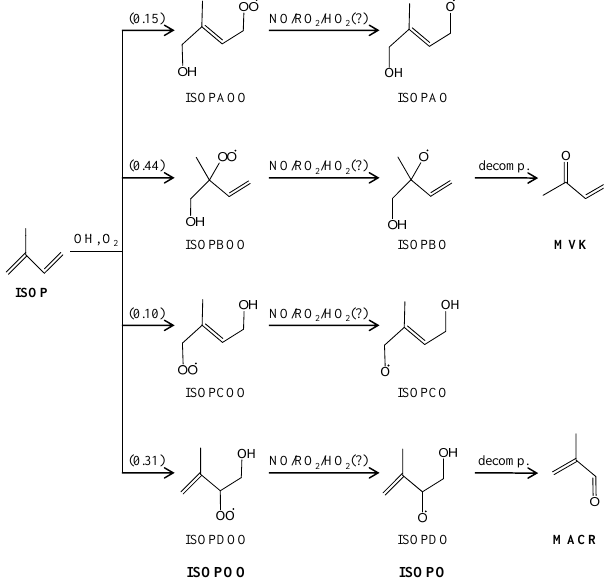
Fig. 1. Mechanism of isoprene oxidation to produce MVK and MACR as first-generation products. Results are shown for NO and RO 2 pathways, as represented in MCM v3.2. Branching ratios to specific products are shown in parentheses. The present study evalu- ates the extent, represented by the question mark, to which ISOPOO alkyl peroxy radicals might react with HO 2 to produce ISOPO alkoxy radicals (Reaction R1b) and thereby MVK and MACR (Re- actions R2 and